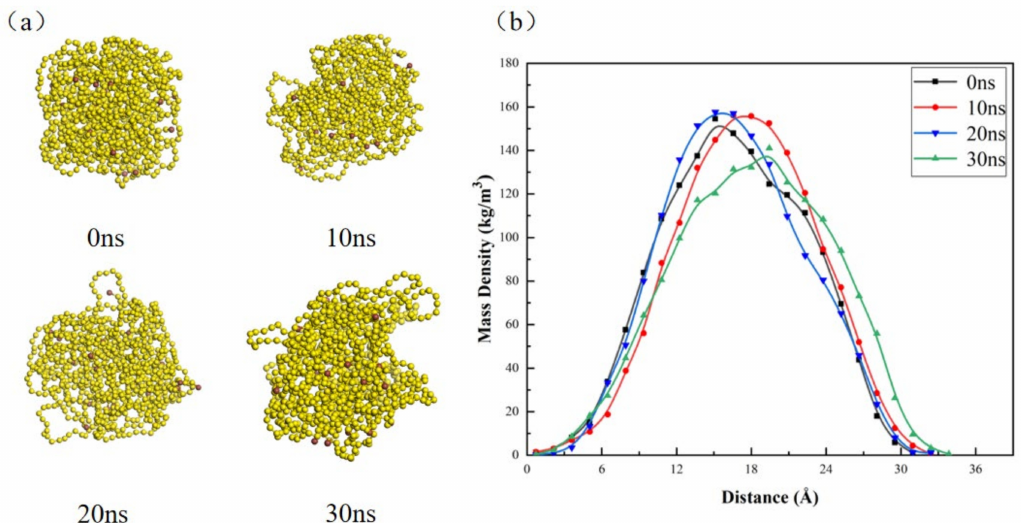
Figure 8. ( a ) The change diagram of IS cluster with simulation time in B-333 model (CS 2 molecule is omitted); ( b ) the graph of mass density of IS clusters with simulation time.